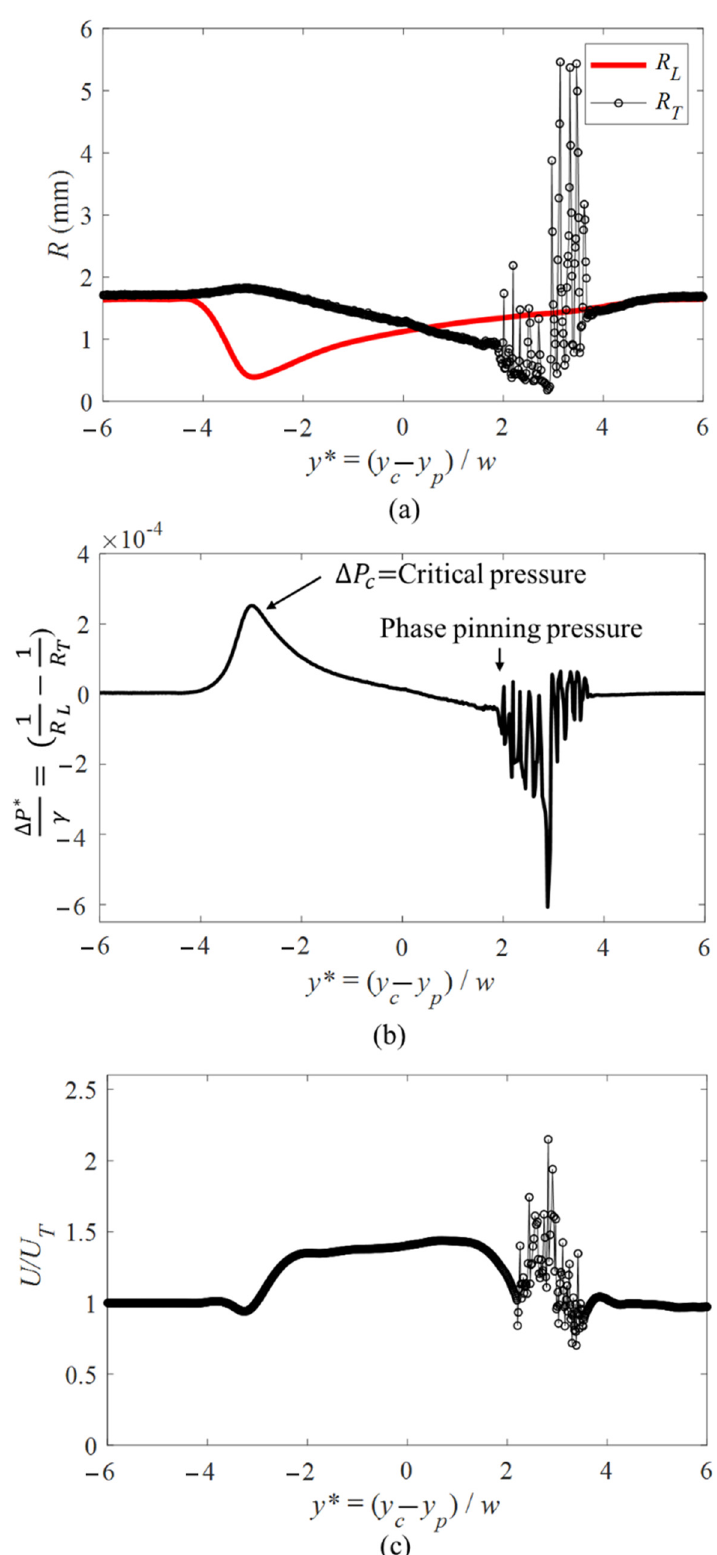
Figure 10. Plots of ( a ) change in the radii of curvature of leading and trailing edge of a bubble, ( b ) pressure along the bubble, and ( c ) velocity of the centroid of a bubble ( R b ∼ 1.95 mm) passing through a circular pore with 0.2 mm roughness on the surface (Sample images of different conditions are shown in Figure 6II)